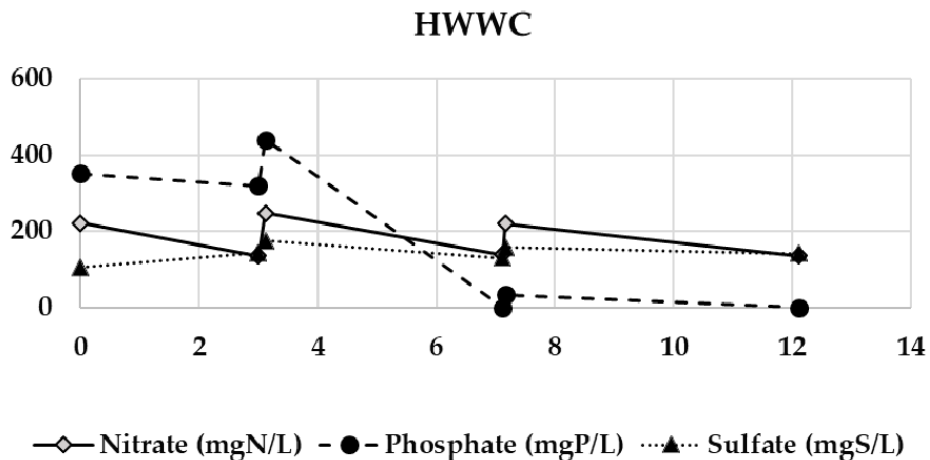
Figure A6. Evolution of the nitrate, phosphate, and sulfate concentrations during the semi-continuous test for consortium B1.